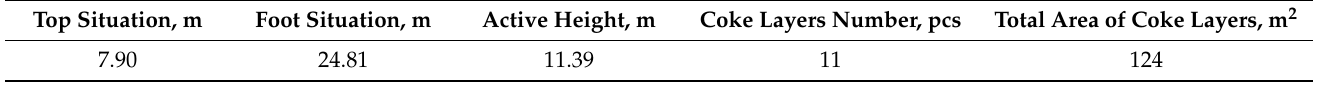
Table 5. Cohesive zone